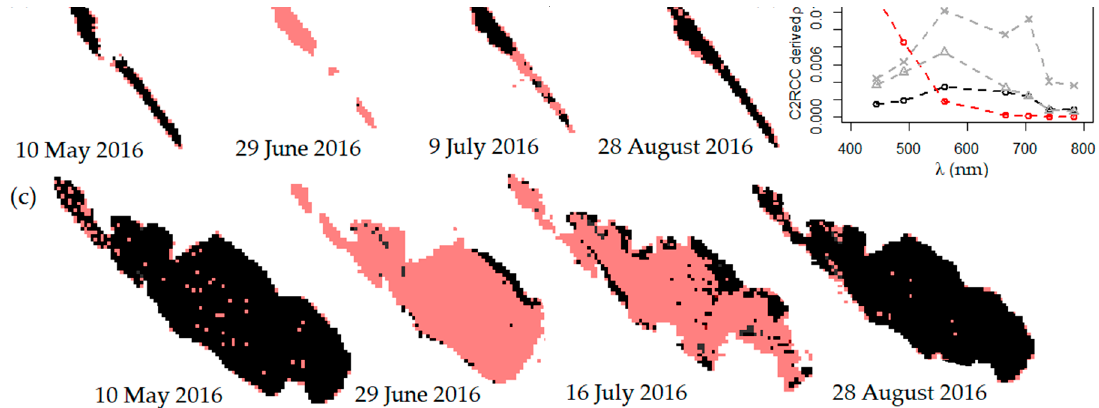
Figure 5. Time series of Raigastvere (a) and Saadjärv (c), where red areas (and the red spectra) show the condition band 3 < band 1 and black areas (and the black spectra) represent water pixels (b), grey triangles represent Raigastvere in situ spectrum and grey stars, Saadjärv in situ measured spectrum.